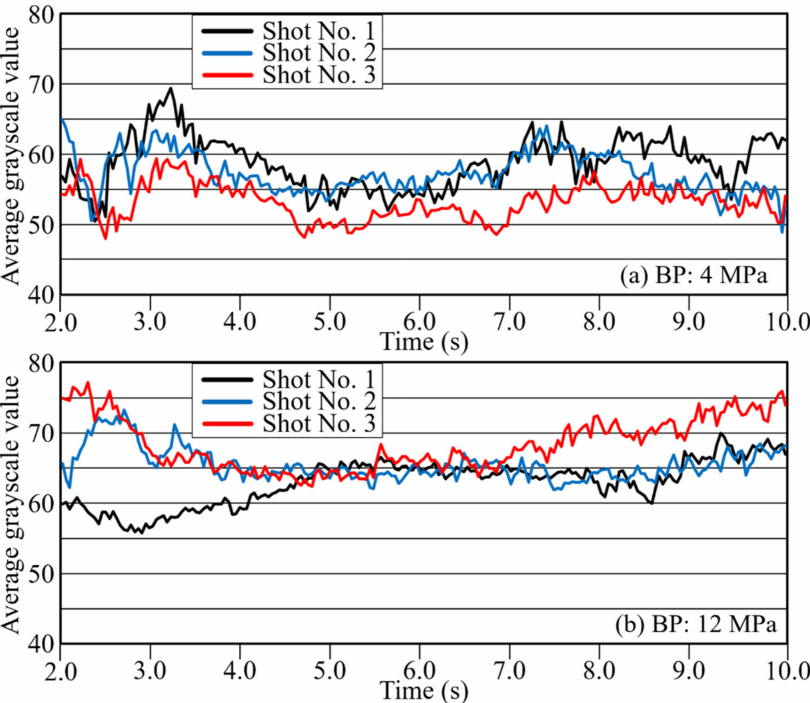
Figure 4. Change curves with time of average grayscale under a back pressure (BP) of ( a ) 4 MPa and ( b ) 12 MPa (glass fiber reinforced polypropylene